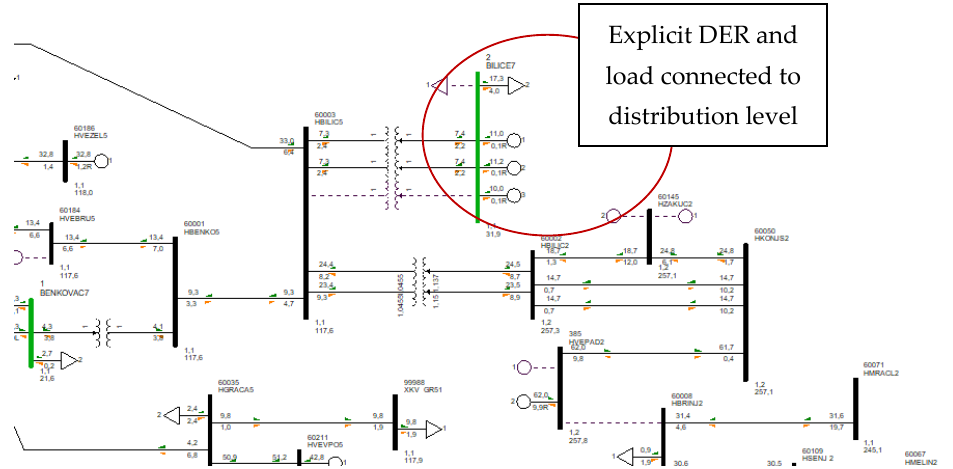
Figure 7. Calculated power flow and voltages of analysed power transmission system–explicit DER and load–upstream load flow.